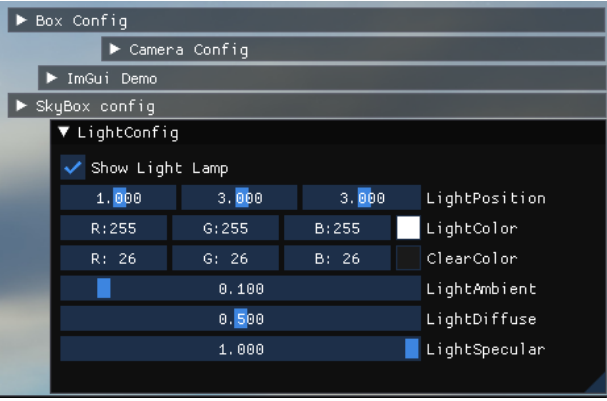
Figure 11. A UI window for configuring a game